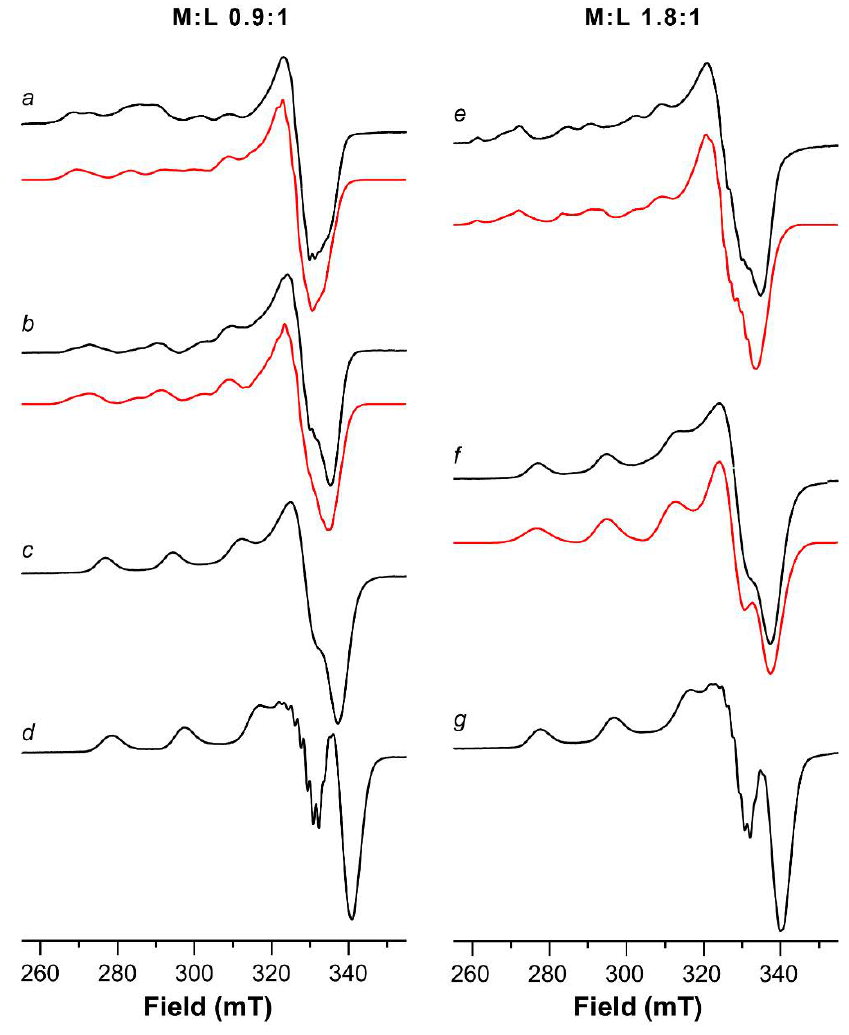
Figure 2. ESR spectra at 150 K of 63 Cu(II)-Ang1-17 system ( a – d , M:L 0.9:1) and 63 Cu(II)-Ang1-17 system (e.g., M:L 1.8:1) in aqueous solution as a function of the pH: ( a ) 3.9 subtracted from the [ 63 Cu(H 2 O) 6 ] 2+ features; ( b ) 4.5; ( c ) 7.3; ( d ) 10.5; ( e ) 5.5 (subtracted from the spectrum at pH = 6.0); ( f ) 7.4; ( g ) 10.0. Simulated spectra are shown by the red line. Raising the pH value to 4.5 (Figure 2b), the [CuLH] isomer (g || =